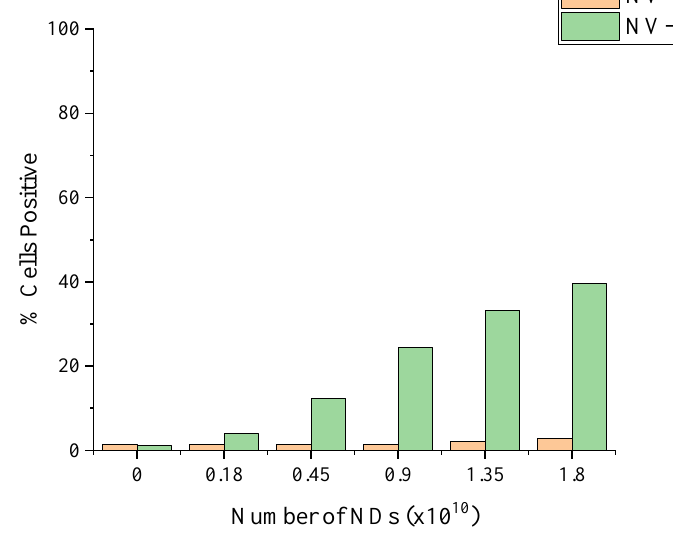
Figure 9. Comparison of the percentage of cells positive with various numbers of NV-40 and NV-90 NDs. Fluorescence intensity was measured using the FL3 filter (670 LP), where 10,000 events were counted.